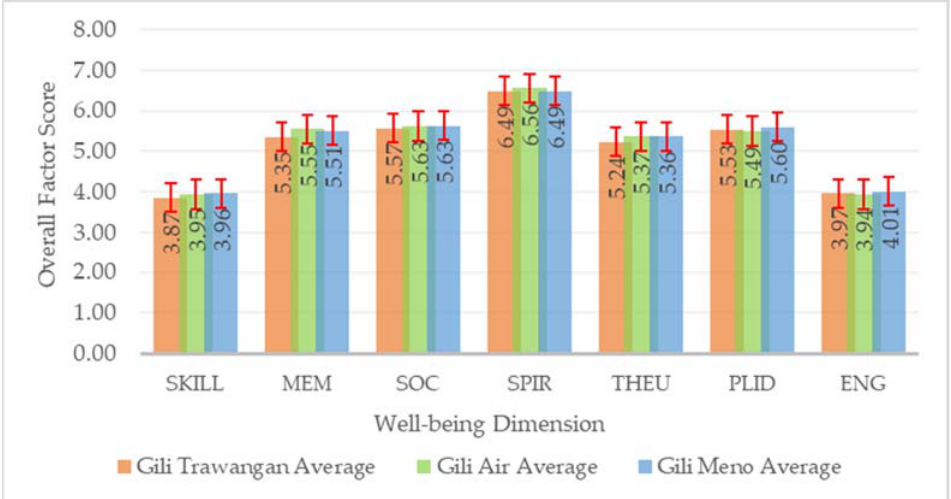
Figure 12. Overall factor scores averages and standard deviation for each